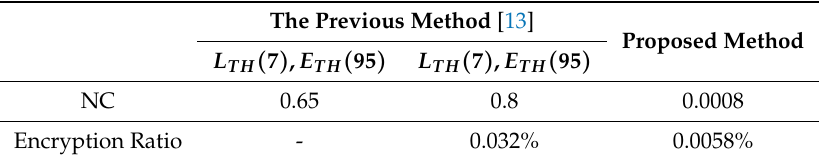
Table 3. Comparison with previous